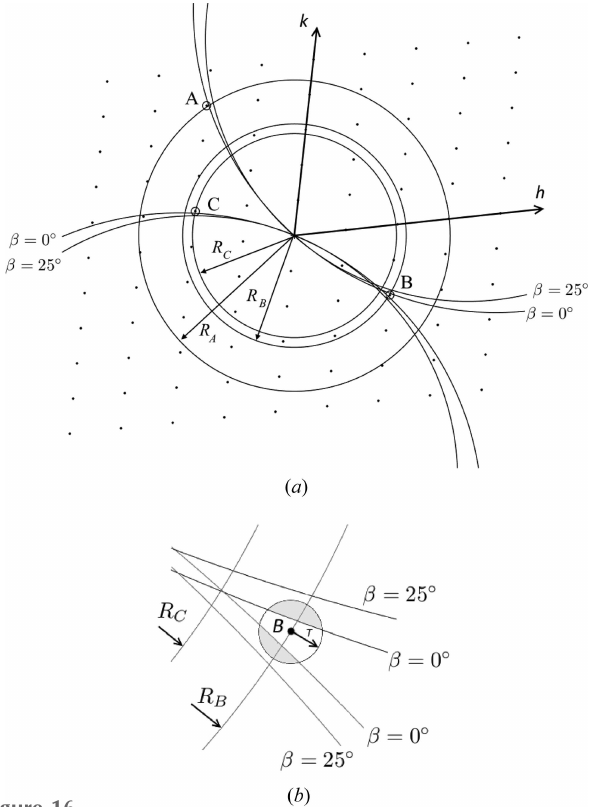
Figure 16 Illustration of fitting Ewald sphere sections, of radius cos( (cid:2) )/ (cid:3) , to pairs of reciprocal-lattice points. ( a ) Three observed peaks with radii R R , and specimen tilts between 0 and 25 (cid:3) , are considered. The best C indexings for (cid:2) = 0 (cid:3) and (cid:2) = 25 (cid:3) are shown. The indexing of both pairs of radii share the common reciprocal lattice point B . ( b ) A close-up around reciprocal lattice point B . In both indexing cases, the Ewald sphere never intercepts point B for the range of (cid:2) values present (0 (cid:3) , 25 (cid:3) ). Moreover, indexing is not possible for (cid:2) larger than particular values as the Ewald sphere is not within the accepted tolerance radius T of the reciprocal lattice point B . As a result, only the regions shaded grey can accrue diffraction for the two indexing scenarios, leading to a fragmented intensity distribution about the reciprocal lattice point B in the merged